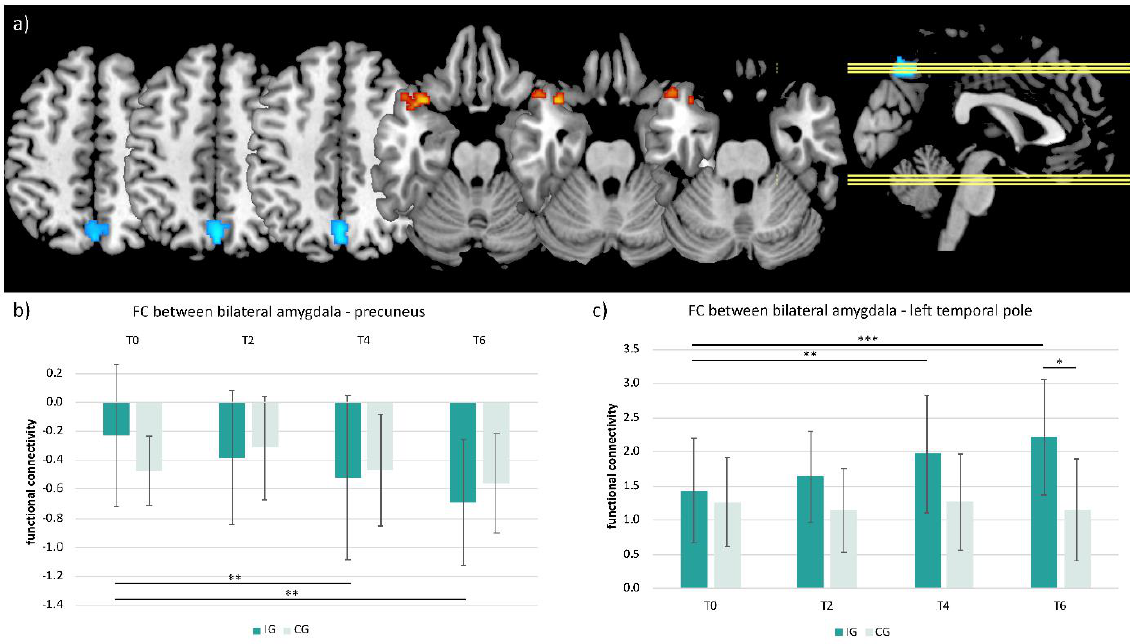
Figure 4. Significant bilateral amygdala FC changes derived from the time effect within the inter- vention group. ( a ) Showing the clusters within the precuneus (blue) and the temporal pole (red- yellow) (threshold: p < 0.001 uncorrected, alpha level = 0.05, k ≥ 58 voxels); ( b ) shows the amygdala – precuneus FC (mean ± standard deviation) extracted from the precuneus cluster for all timepoints (T0, T2, T4, and T6) and both groups (IG and CG); ( c ) shows the amygdala – right temporal pole FC (mean ± standard deviation) extracted from the cluster in the temporal pole for all timepoints (T0, T2, T4, and T6) and both groups (IG and CG; FC = resting state functional connectivity; T0, T2, T4, T6 = examination day after 0, 2, 4, 6 months; IG: N = 18 ( N = 16 at T6), CG: N = 10; *** p < 0.001, ** p < 0.01, * p < 0.05.